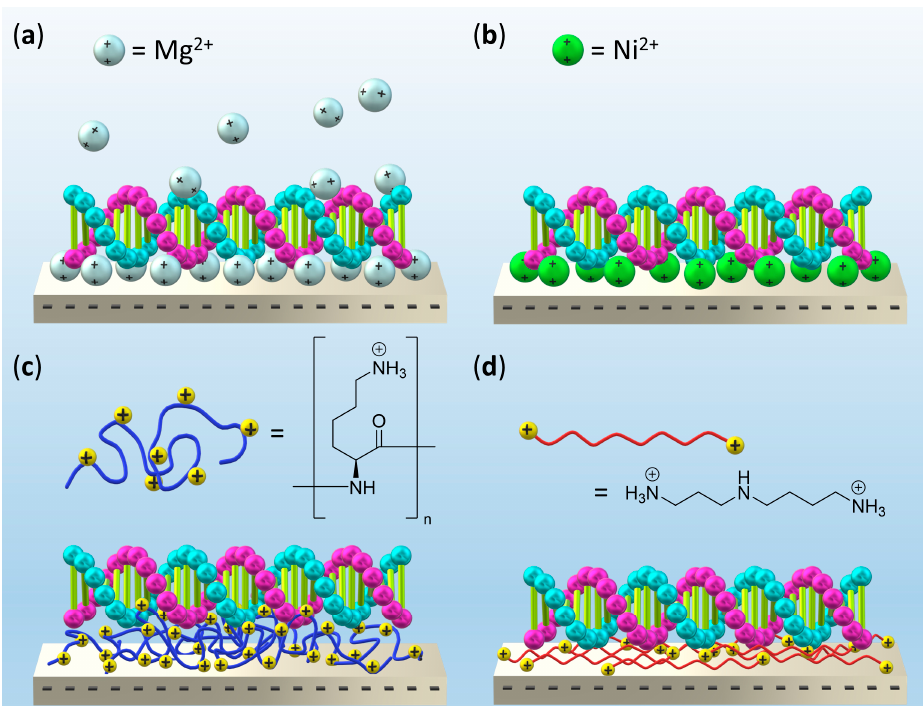
Figure 1. Schematic representations (not to scale) of the different DON adsorption strategies evalu- ated in this work. ( a ) Addition of Mg 2+ ions to the DON sample. ( b ) Pre-adsorption of Ni 2+ ions. ( c ) Pre-adsorption of poly- L -lysine (PLL). ( d ) Pre-adsorption of spermidine (Spdn). The backbone of double-stranded (ds) DNA is represented by cyan and magenta spheres.